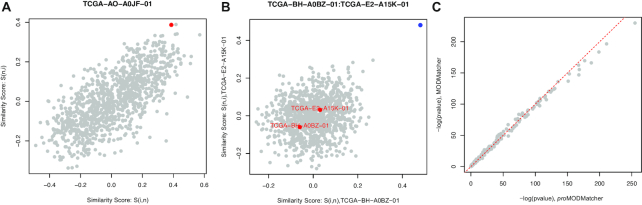
Comparison of MODMatcher and proMODMatcher for aligning expression profiles by RNAseq and miRNAseq data. (A) The similarity scores of a self-aligned RNAseq-miRNA profile pair identified by proMODMatcher but not by MODMatcher. The x-axis indicates the similarity score between the RNAseq profile of TCGA-AO-A0JF-01 and the miRNAseq profiles of all other samples, and the y-axis indicates the similarity score between the miRNAseq profile of TCGA-AO-A0JF-01 and the RNAseq profiles of all other samples. The red dot indicates the similarity score for self-self RNAseq-miRNAseq profiles. (B) One cross-aligned pair, RNAseq of TCGA-BH-A0BZ-01 and miRNA of TCGA-E2-A15K-01, identified by proMODMatcher. The similarity score of the cross-aligned pair is shown in blue, and the similarity scores of self-self alignments are shown in red. (C) Significance levels of cis-associations based on profile pairs aligned by MODMatcher and proMODMatcher.